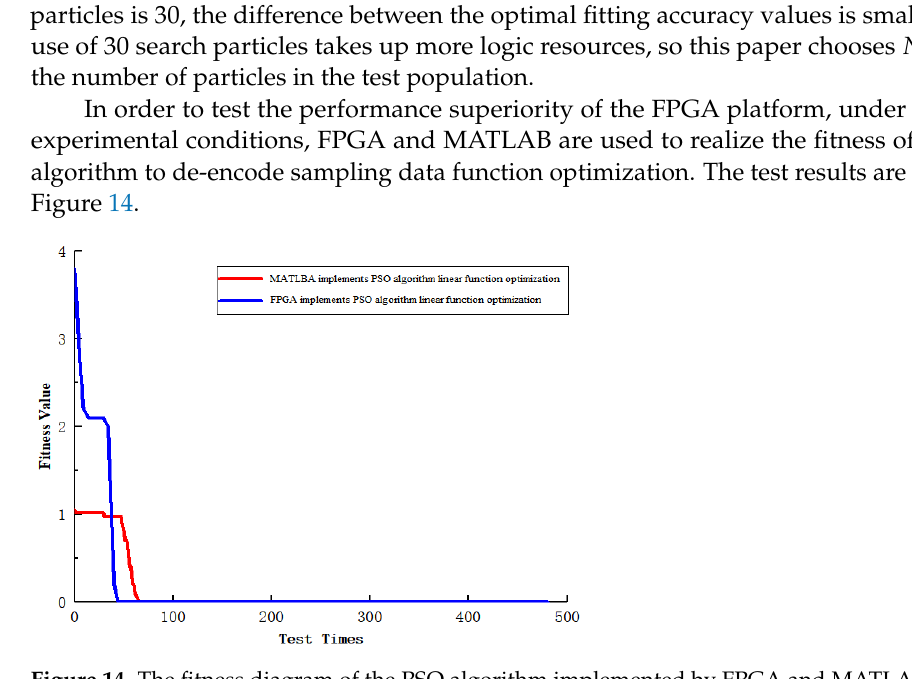
Figure 14. The fitness diagram of the PSO algorithm implemented by FPGA and MATLAB.